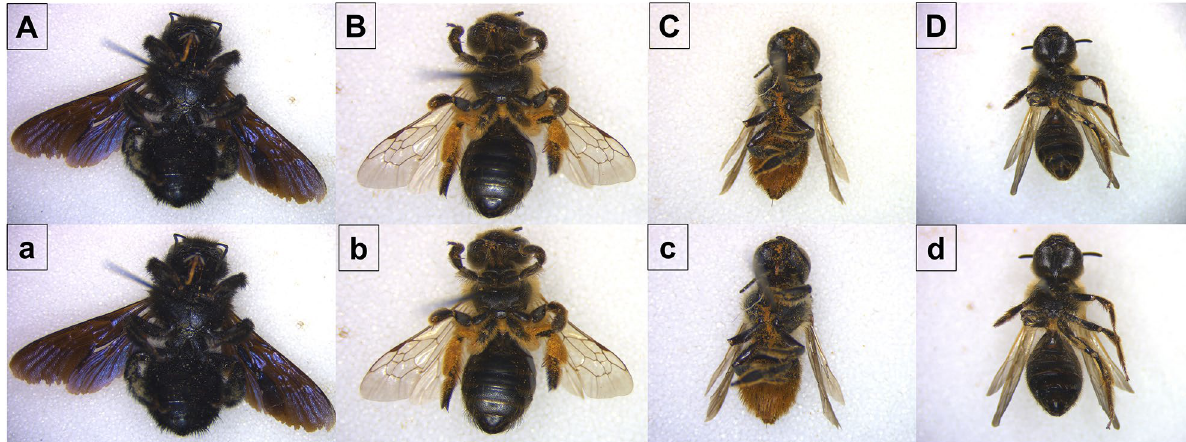
Figure 3. Ventral pictures of four bee individuals before ( A – D ) and after (a,b,c,d) the treatment using the swabs soaked with the digestion buffer. ( A )/a Xylocopa violacea (L., 1758) (collected in Emilia-Romagna region in 2011), ( B )/b Andrena flavipes (Panzer, 1799) (collected in Tuscany region in 1994), ( C )/c Megachile centuncularis (L., 1758) (collected in Umbria region in 1996), ( D )/d Andrena lagopus (Fabricius, 1775) (collected in Latium region in